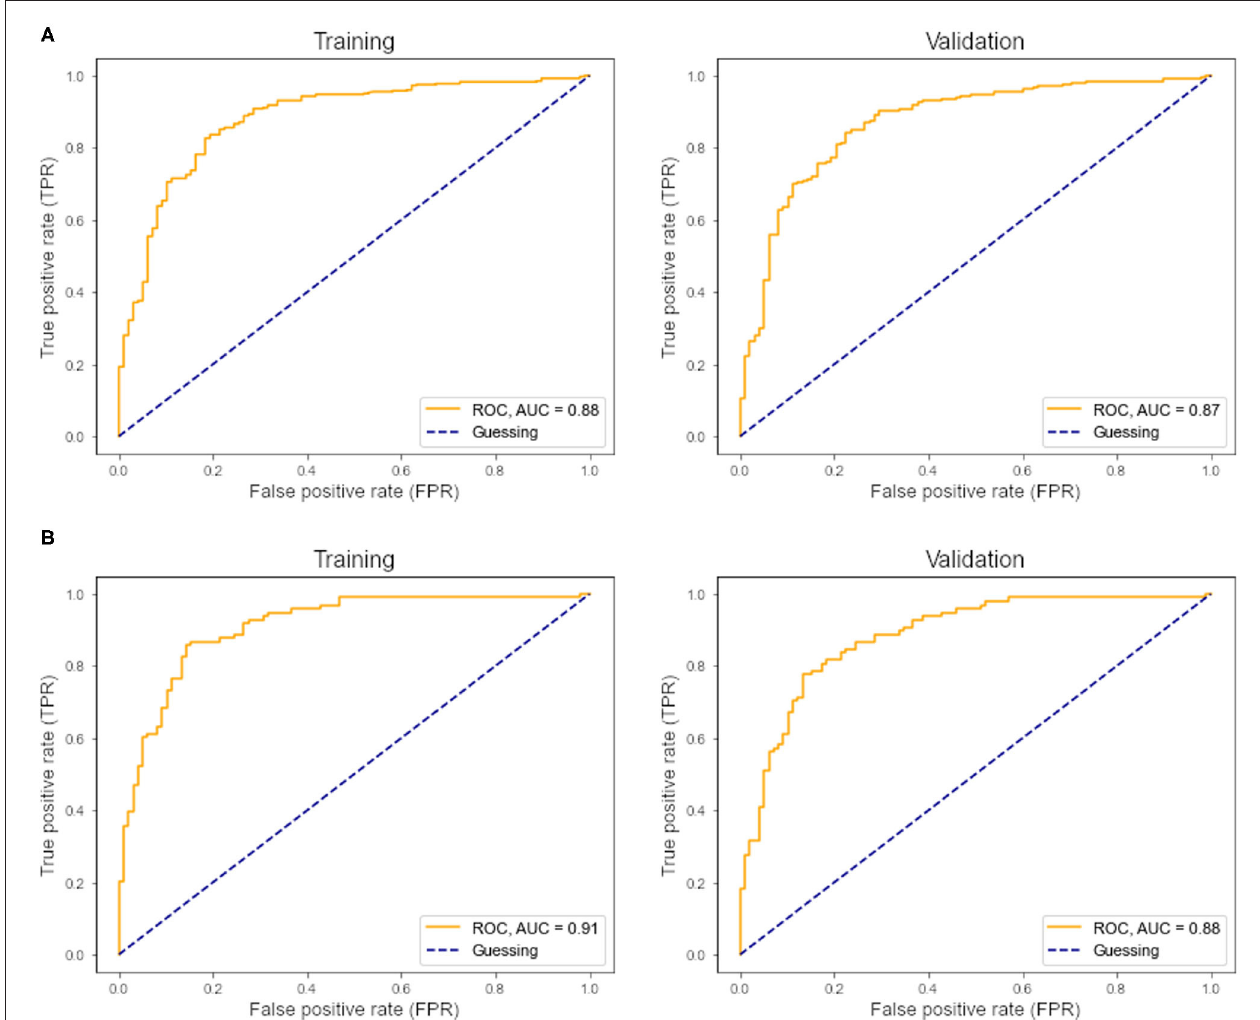
FIGURE 2 | (A) ROC curve and AUC from the support vector classifier. Left, training sample; right, leave-one-out cross-validation. (B) ROC curve and AUC from the multilayer perceptron classifier. Left, training sample; right, leave-one-out cross-validation.